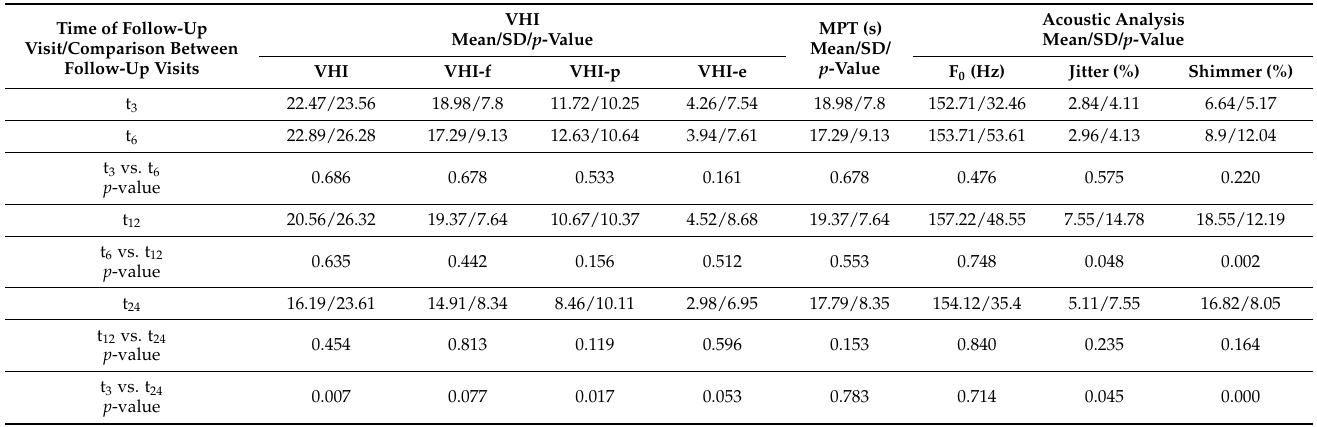
Table 2. Results of the Voice Handicap Index (VHI) questionnaire, measurement of maximal phona- tion time, and acoustic analysis of voice samples over the 24 months after radiotherapy in patients with T 1 glottic carcinomas ( N =